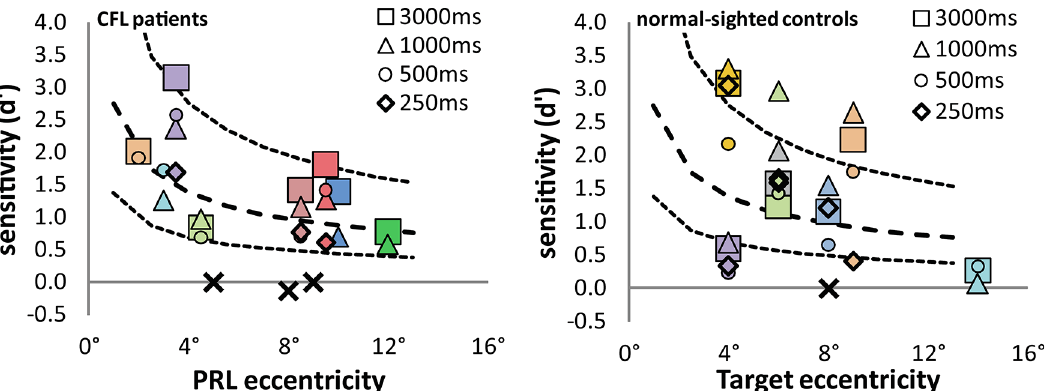
Fig 2. Left panel : CFL patient results, plotted as d' (signal-noise ratio) against estimated PRL eccentricity. Each color represents a different subject; different symbols are different presentation times as indicated in the legend. The X symbols are subjects who would not complete one block of trials (claiming to be unable to do the task), plus one patient (C11, the slightly negative d ’ around 8°) who gamely completed 100 trials despite claiming not to know what the target looked like. The thick dashed line is a power function fitted to the data; the thin dashed lines are half and double the fitted line. Right panel : Normal control data, same conventions as for the CFL data. The lines are the same as in the first